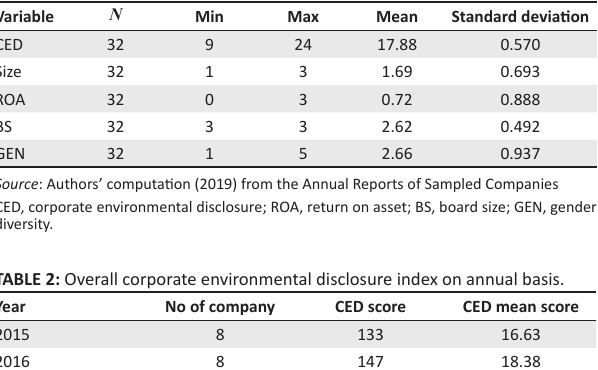
TABLE 1: Descriptive statistics of variables under study.